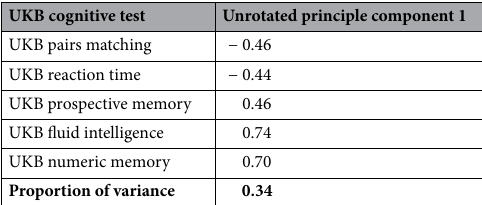
Table 1. Loadings from a principal component analysis of 5 UK Biobank tests ( n = 48,749). Eigenvalues and scree plot indicated one component. Unrotated findings are